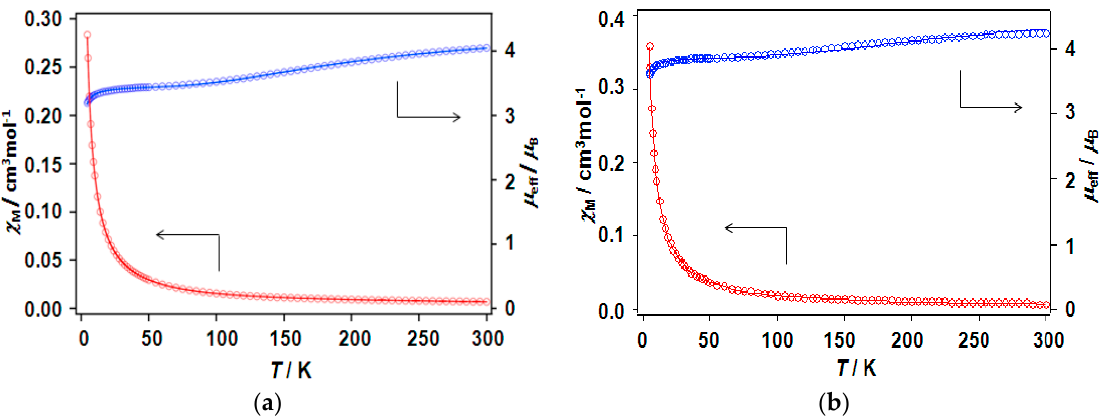
Figure 12. Temperature dependence of magnetic susceptibilities (red circles) and magnetic moments (blue circle) of chain compounds ( a ) [Cu 2 (caproxy) 4 (pds)] n ( 6 ) and ( b ) [Cu 2 (catempo) 4 (4,4 ′ -bpy)] n ( 9 ).